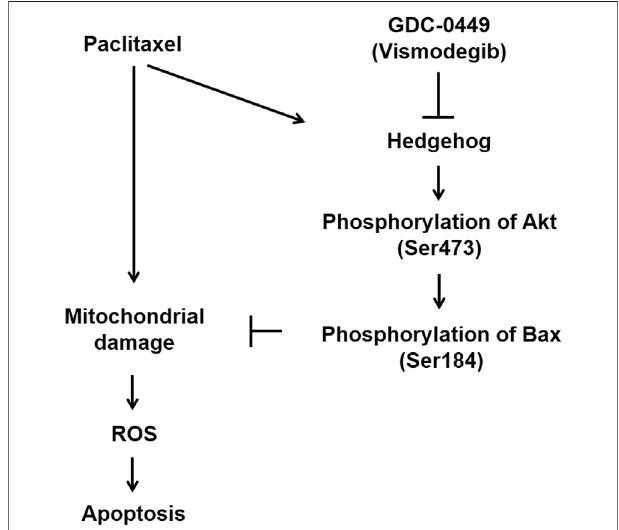
FIGURE 6 | Model of GDC potentiation of PTX-induced apoptosis. Paclitaxel treatment induces apoptosis but is accompanied by activation of the protective hedgehog pathway. Hedgehog induces phosphorylation of Akt (Ser473), which in turn phosphorylates Bax at Ser184. Phosphorylated Bax is unable to translocate to mitochondria. Thus, hedgehog-mediated Bax phosphorylation renders EGFR WT NSCLC cells resistant to paclitaxel- induced apoptosis. GDC-0449 attenuates hedgehog signaling activation, potentiating paclitaxel-induced